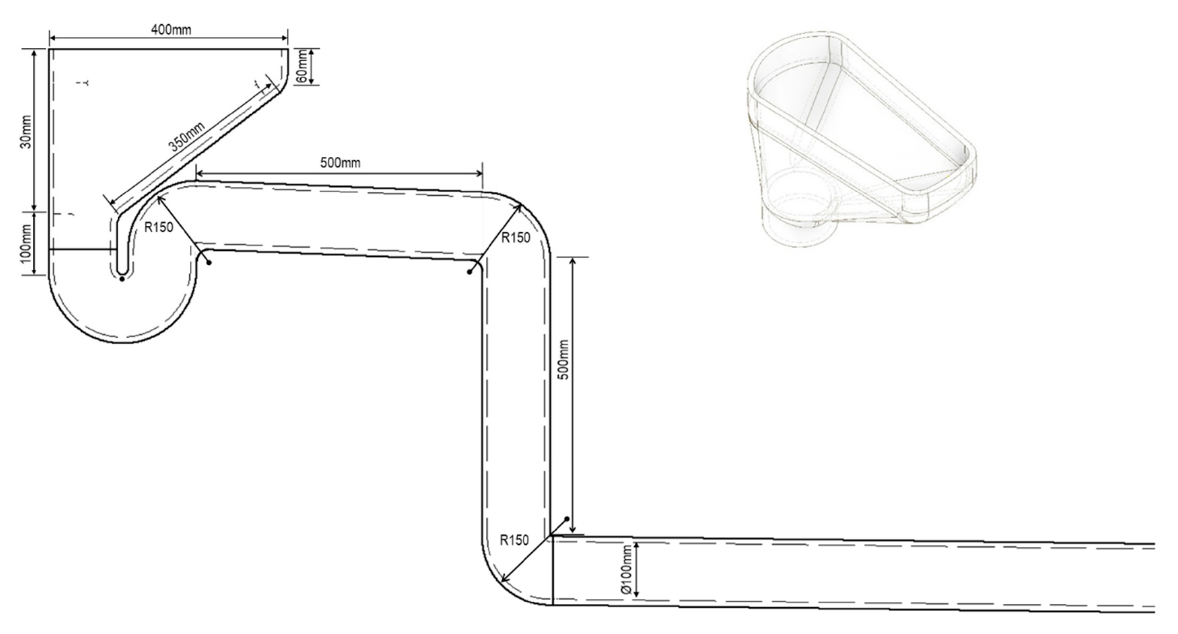
Figure 1. Dimensioned elevation, and isometric, of the system under consideration in this study. DualSPHysics was used as the smooth particle hydrodynamic (SPH) model in the study. DualSPHysics is an open source smoothed particle hydrodynamics (SPH) model, originating from SPHysics code, developed by researchers at the University of Manchester, John Hopkins University, University of Vigo, and University of Rome SPH originated within astrophysics to provide reasonable accuracy whilst being sim- ple to work with [9,10], where the equations of fluid dynamics replace the fluid with par- ticles, interpolation points, which can then be used to determine properties of the fluid. The particle representation conserves energy, momentum (linear and angular), mass, and entropy (if no artificial viscosity operates), whilst unlike alternative Eulerian mesh-based techniques like Computational Fluid Dynamics (CFD), SPH algorithms are Galilean in- variant [11].